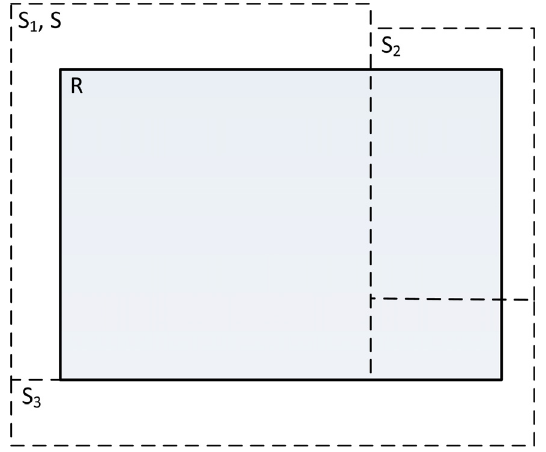
Figure 7. An abstract segmentation evaluation scenario with the reference segment denoted by R , the generated segments by S overlap with R as S